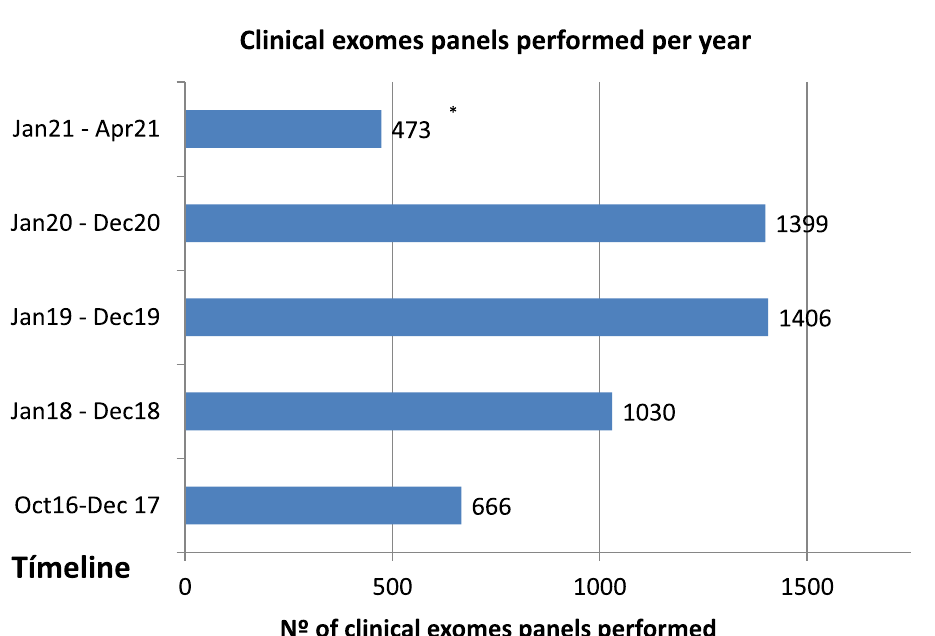
Figure 2. Number of clinical exomes panels performed in our laboratory per year. * Data of only 4